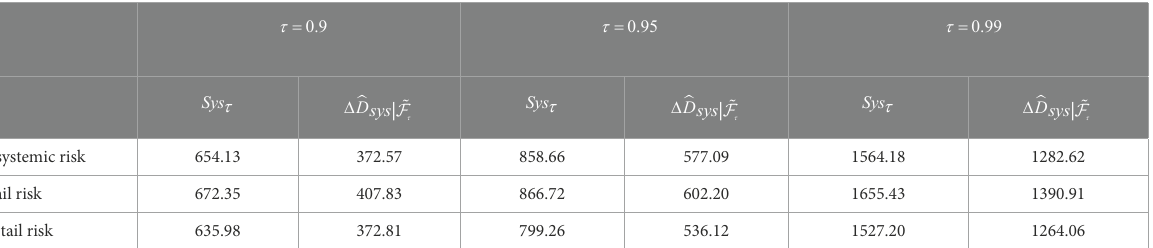
TABLE 6 Systemic risk spillovers under different tail-event shocks.